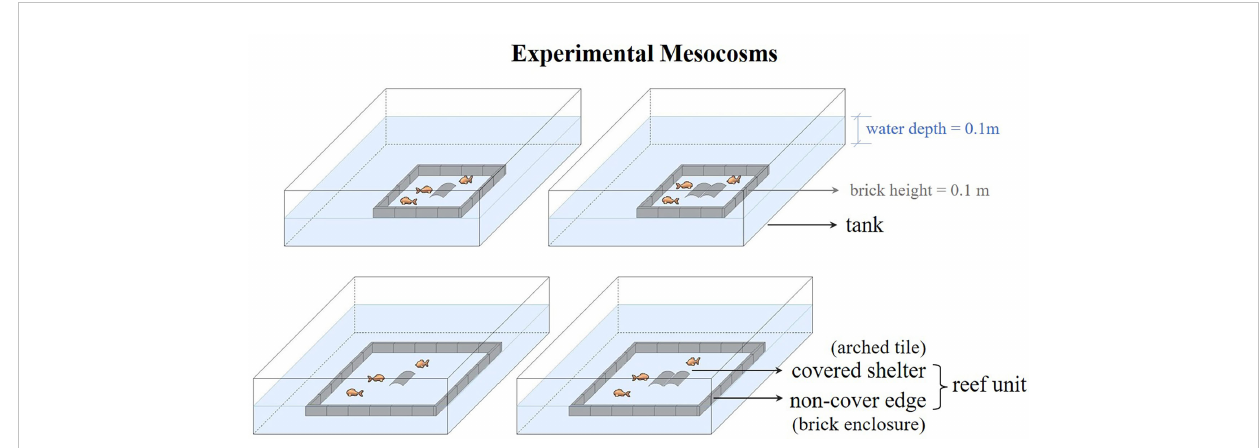
FIGURE 1 Schematic of the experimental mesocosms designed to detect how shelter availability affected the distribution of juvenile fat greenling, Hexagrammos otakii , a benthic reef fi sh. The covered shelter (made of arched tile(s)) and non-covered edge (made of a brick enclosure) made up one reef unit placed in the tank. Water level was kept at brick height to restrict fi sh to move to within the reef